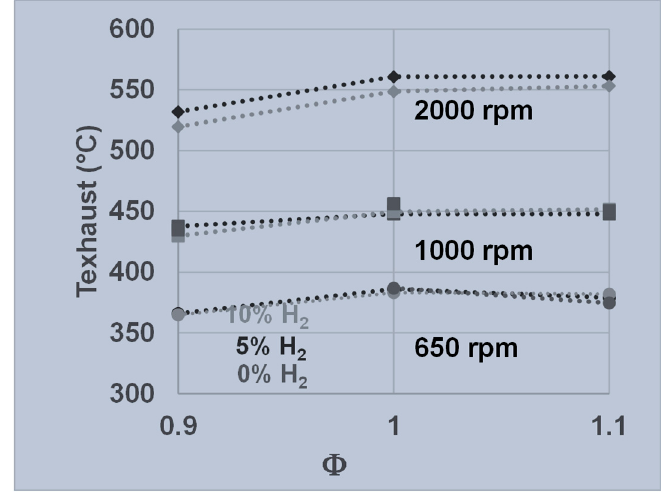
Figure 8. Exhaust temperature vs equivalence ratio. P in =1 bar.